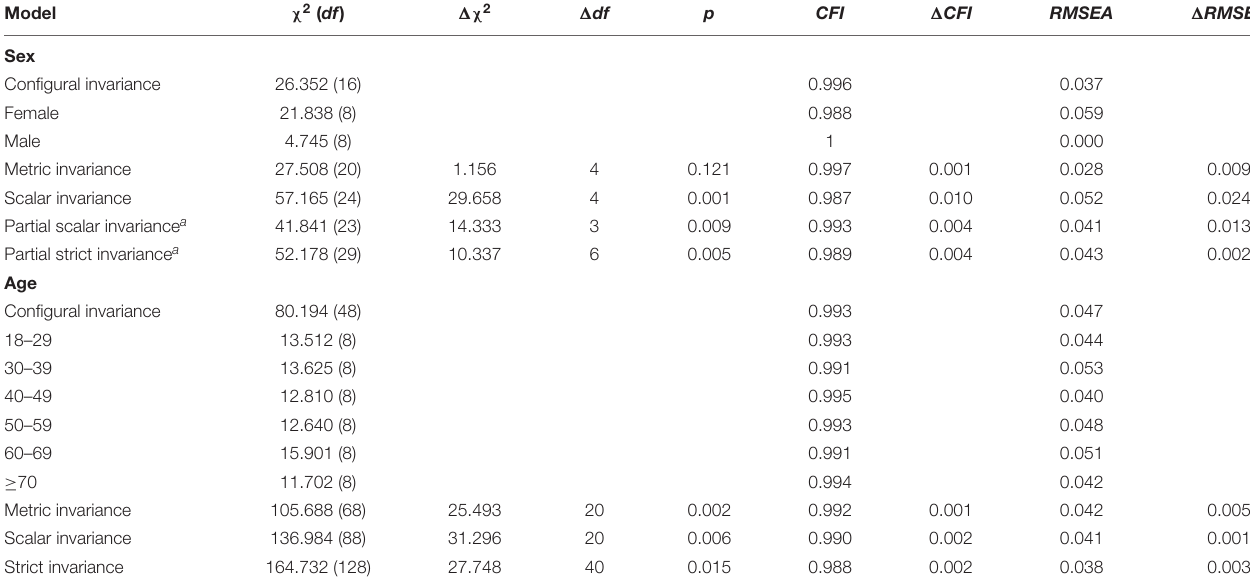
a The intercept of Item 8 was freed to vary between groups.